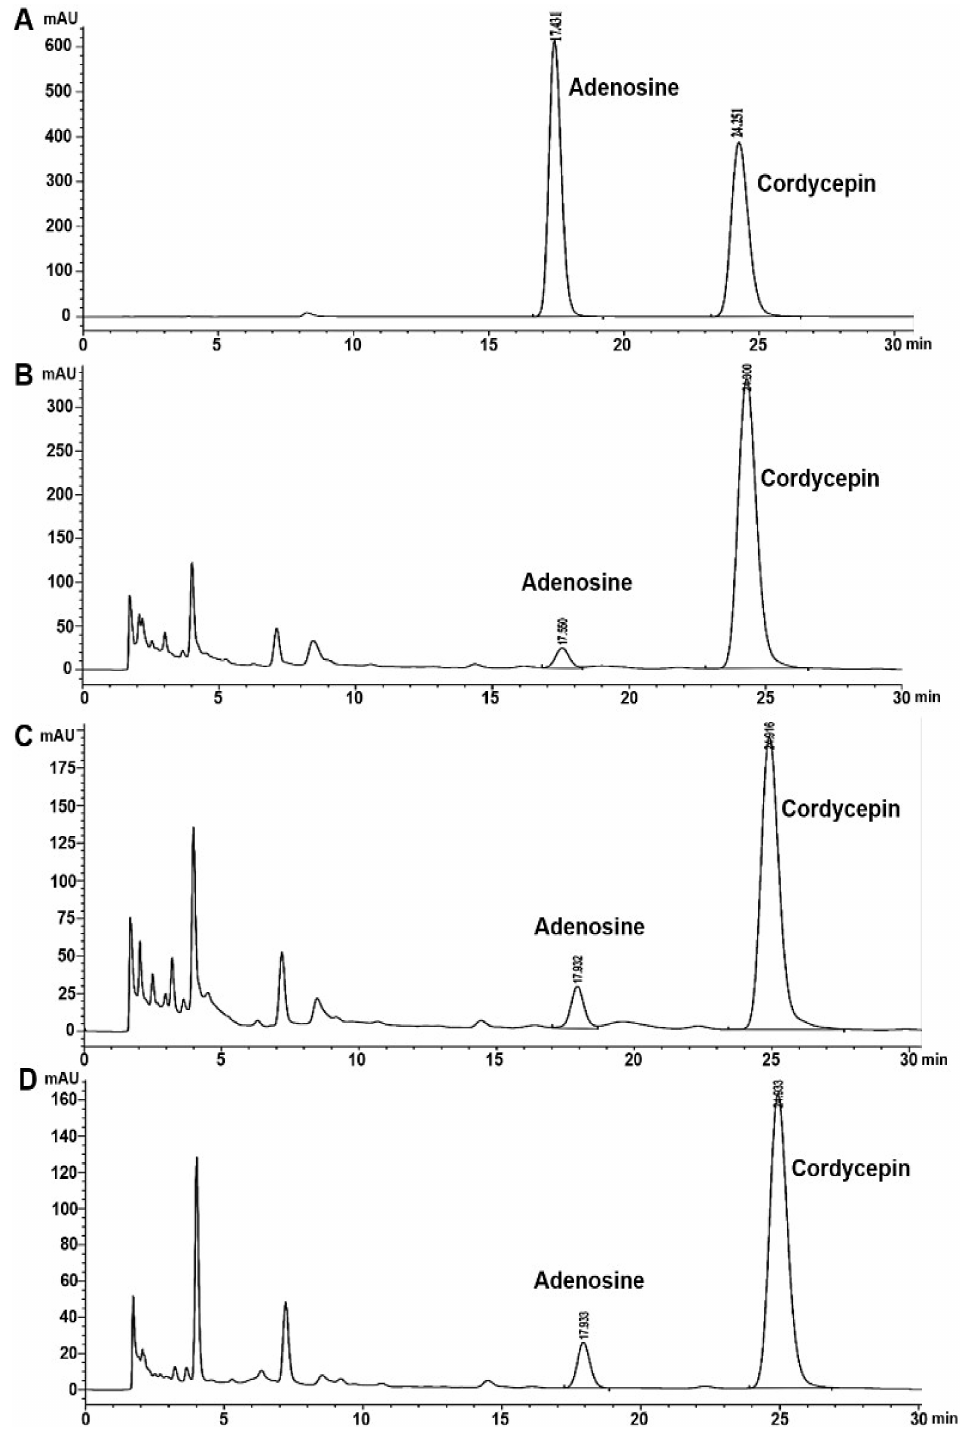
Figure 2. HPLC chromatograms of cordycepin and adenosine founded in the aqueous extracts of C. militaris by HPLC method: ( A ) Standard compounds of cordycepin and adenosine; ( B ) Sample A; ( C ) Sample B; ( D ) Sample